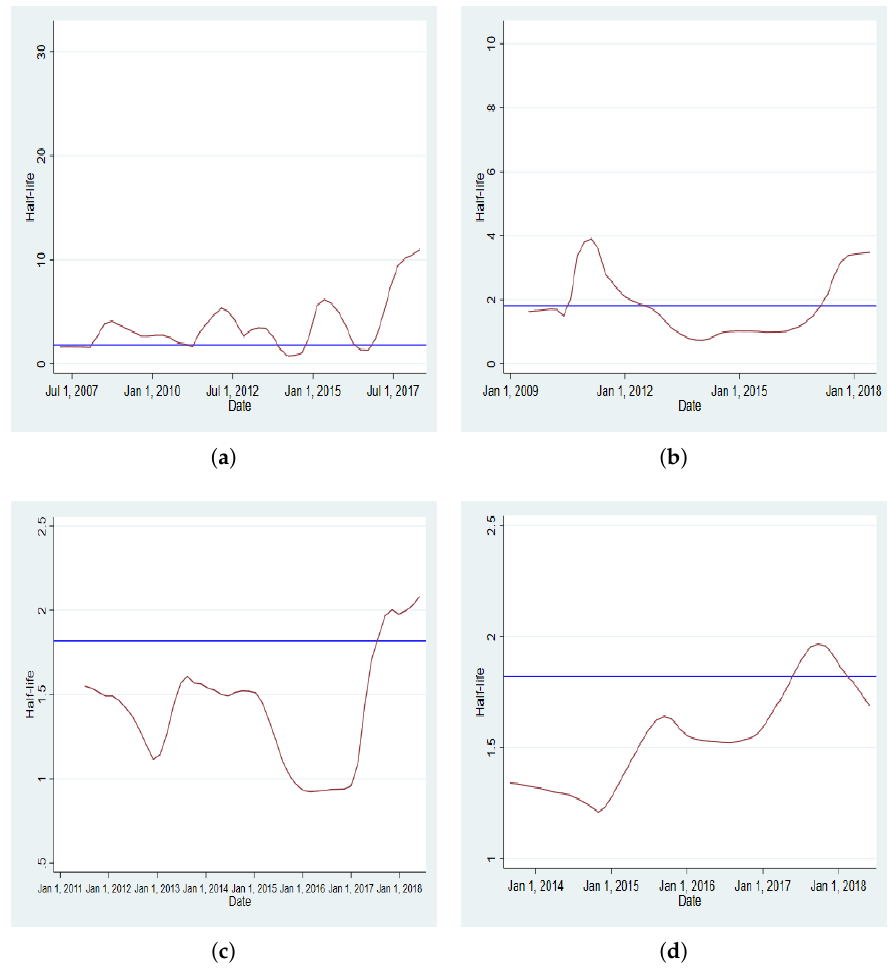
Figure A7. Dynamics of half-time for the BRVM10 index using standard rolling regression. These graphs plot the half-time estimated using rolling regression. The date is the end date for a selected window. In ( a ), the half-time is 1.4 days using recursive rolling regression with a window whose end date is 1 July 2007. ( a ) Dynamics of half-time for the BRVM10 index using standard rolling regression with a 2-year window; ( b ) Dynamics of half-time for the BRVM10 index using standard rolling regression with a 4-year window; ( c ) Dynamics of half-time for the BRVM10 index using standard rolling regression with a 6-year window; ( d ) Dynamics of half-time for the BRVM10 index using standard rolling regression with an 8-year